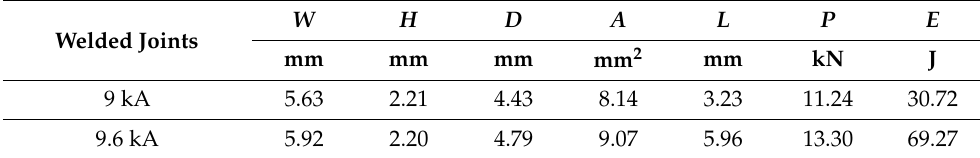
Table 5. The geometries and mechanical properties of the additional welded joints produced by the higher welding currents of 9 kA and 9.6